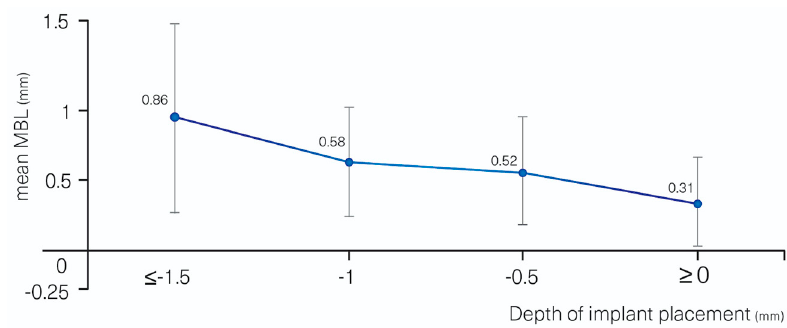
Figure 3. MBL vs. depth of implant placement. Table 3. Association between total MBL and independent variables of patient profile, surgery, and implant characteristics: Wald chi [2] test results of the general linear regression